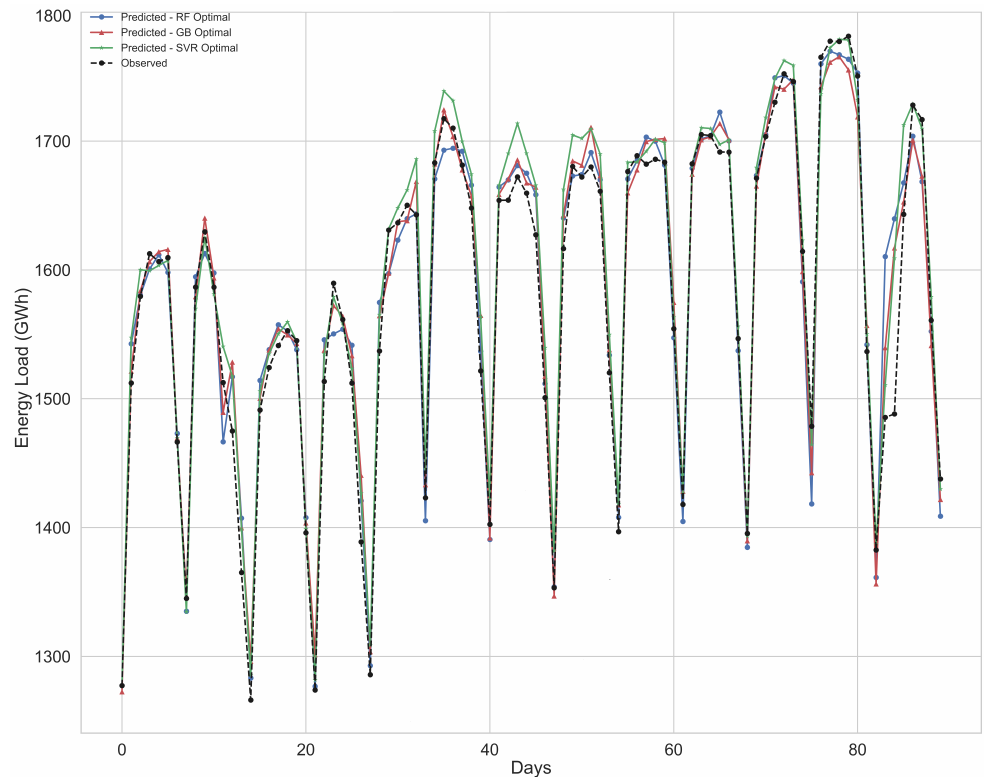
Figure 10. Energy Load predictions (obtained by the optimized forecasting models) × real values for the first quarter of